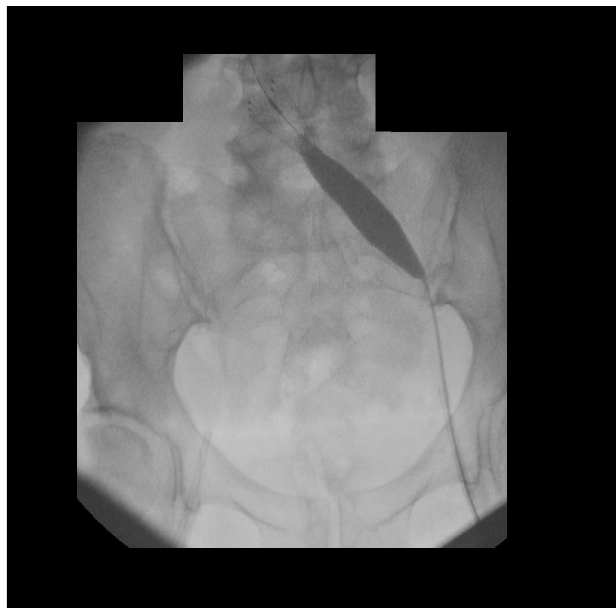
Fig. 2. Frame grab during deployment and balloon dilatation of the stent in Fig.